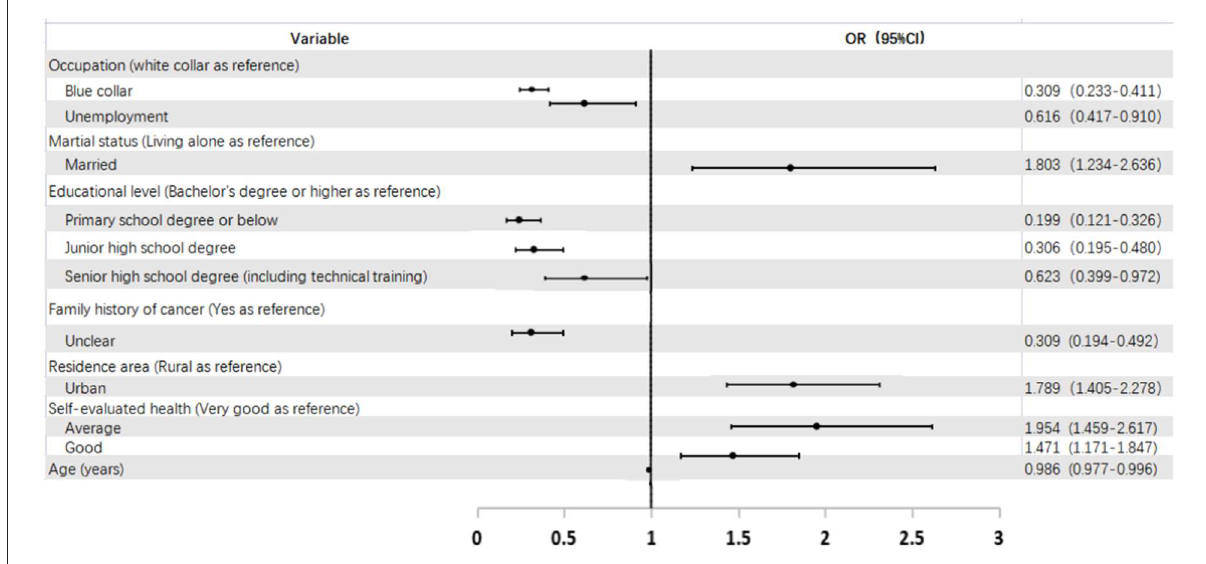
FIGURE2 Forest plot of OR (95% CI) for having a high cancer prevention and control core knowlegde by sociodemographic and other factors in Fujian Province in China.